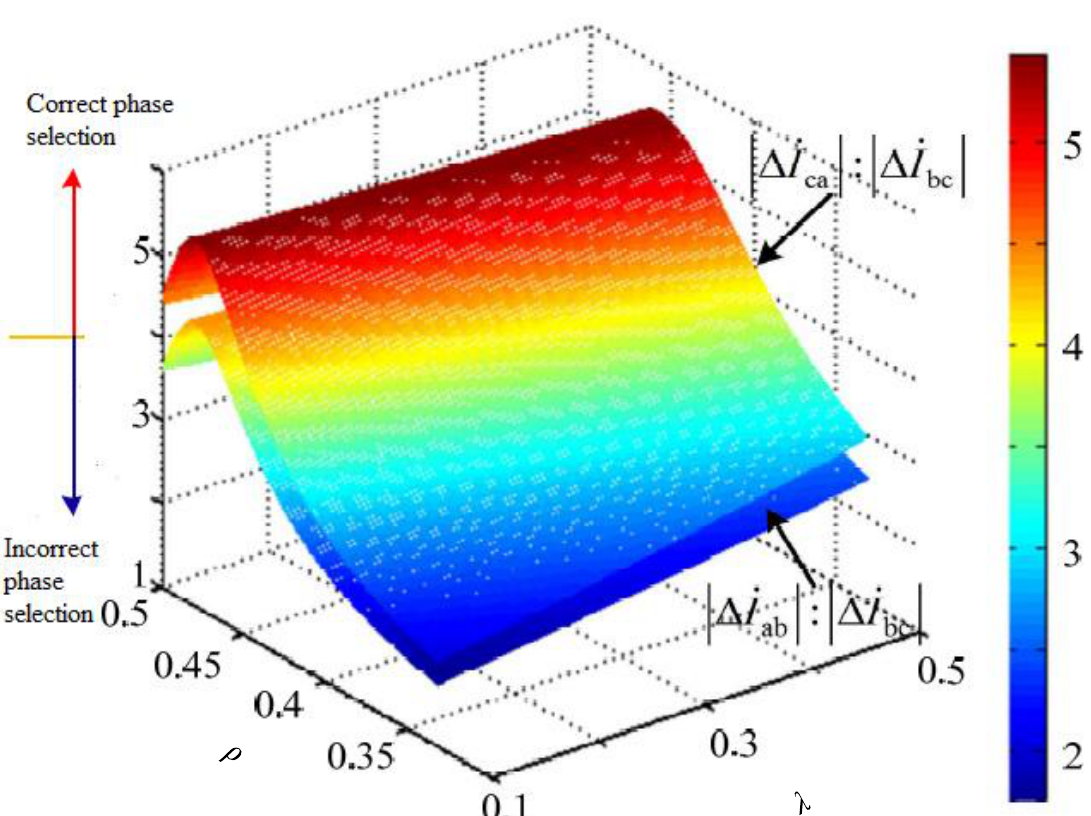
Figure 3. The variation of amplitude ratios with respect to voltage imbalance and positive sequence voltage drop depth parameters.